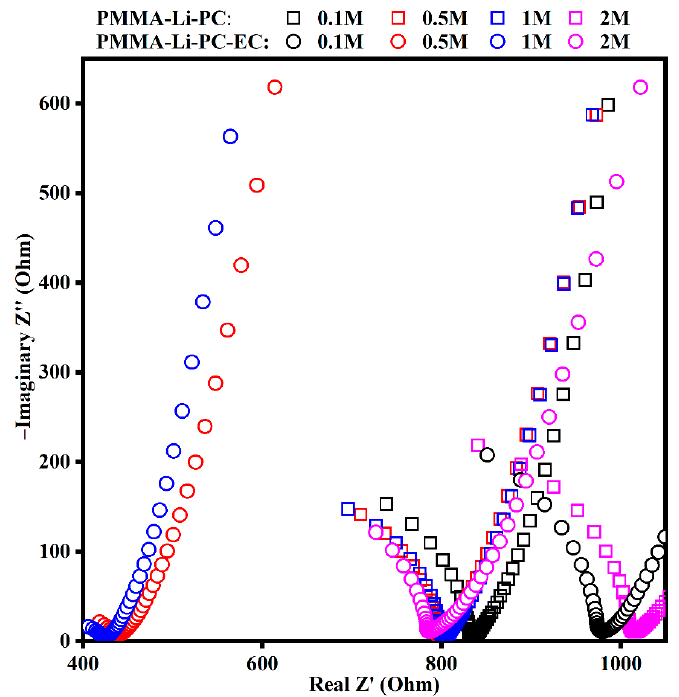
Figure 1. Nyquist plots in the range of 1 Hz to 1 MHz of gel polymer electrolytes PMMA-Li-PC (open squares) and of PMMA-Li-PC-EC (open circles) at different salt concentrations: 0.1 M (black), 0.5 M (red), 1 M (blue), 2 M (magenta).